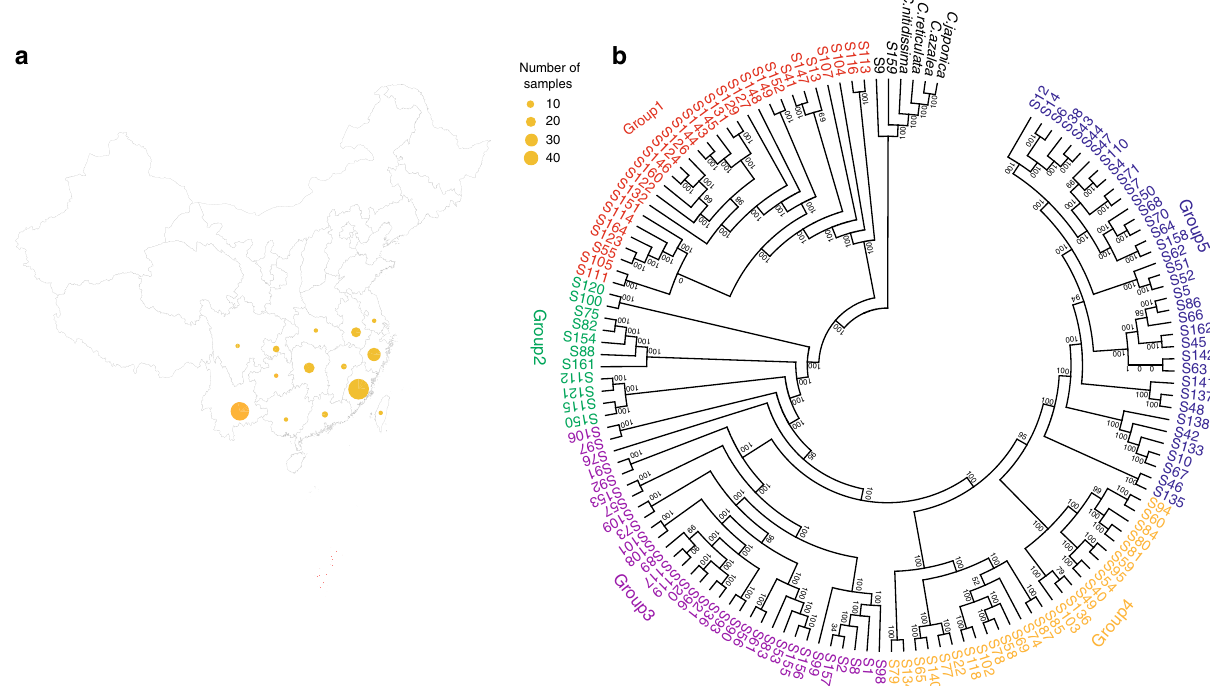
Fig. 1 Geographic origins and phylogenetic relationships of 136 representative tea plant accessions in China. a Geographic origins of the tea plant accessions examined in this study. The map of China was generated using the R package “ chinamap ” (https://github.com/GuangchuangYu/chinamap). b An approximate Maximum Likelihood-based phylogenetic tree constructed using 45,162 fourfold-degenerate SNPs that were identi fi ed from mapped RNA- sequencing data. The tree was rooted using fi ve tea relative species (in black) as outgroup. Numbers at the branch points represent support values (percentage) based on 1000 bootstrapping replicates. Five main clades were identi fi ed and indicated in different colors: group 1 (red), group 2 (green), group 3 (purple), group 4 (yellow), group 5 (blue). Source data underlying b are provided as a Source Data fi